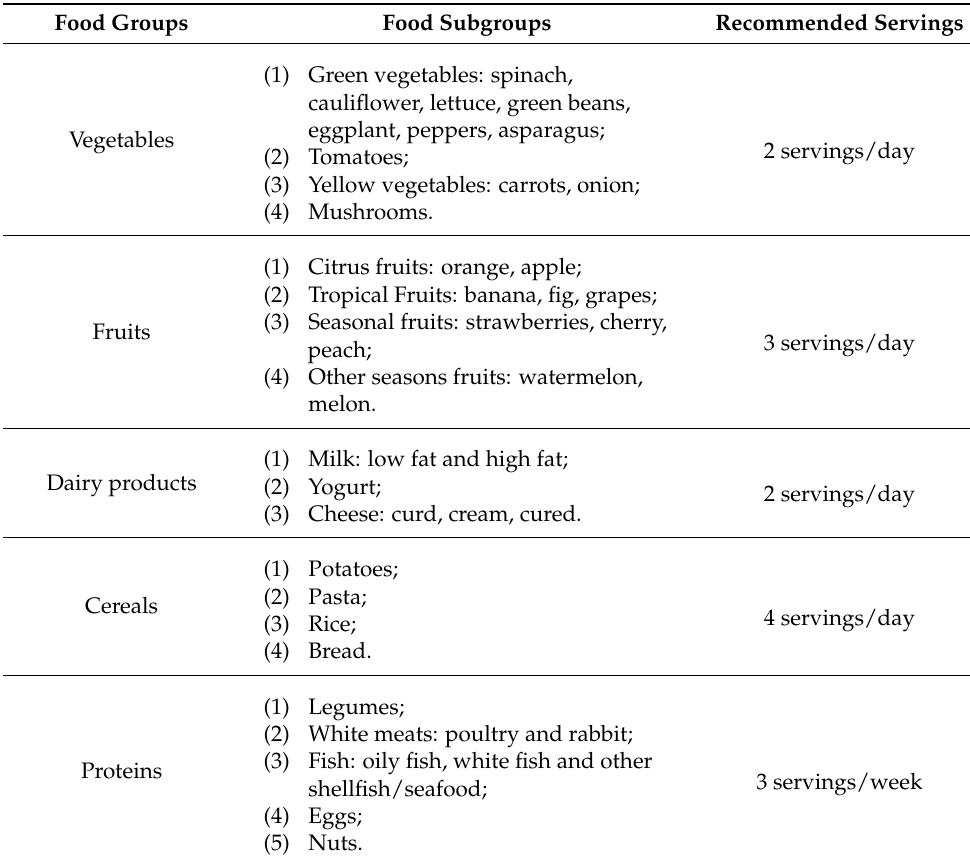
Table 1. Food groups and the recommended servings per day/week used in the dietary diversity score (DDS) according to the Spanish